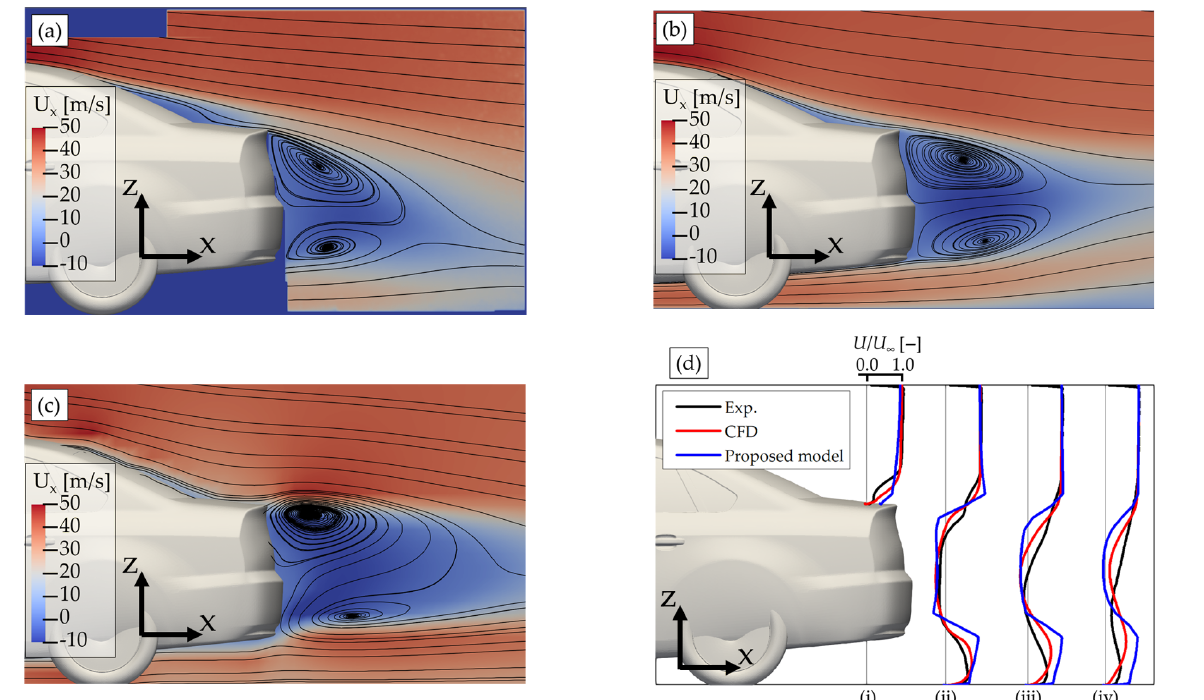
Figure 11. Streamlines and velocity profile in the near-wake region of the notchback vehicle, along the centerline of the y -direction, in the x - z plane. ( a ) Experiment [8], ( b ) CFD model, ( c ) Proposed model ( d ) comparisons of the velocity profiles. Velocity profiles are drawn from the front of the vehicle at downstream positions of ( i ) 1089 mm, ( ii ) 1199 mm, ( iii ) 1314 mm, and ( iv ) 1422